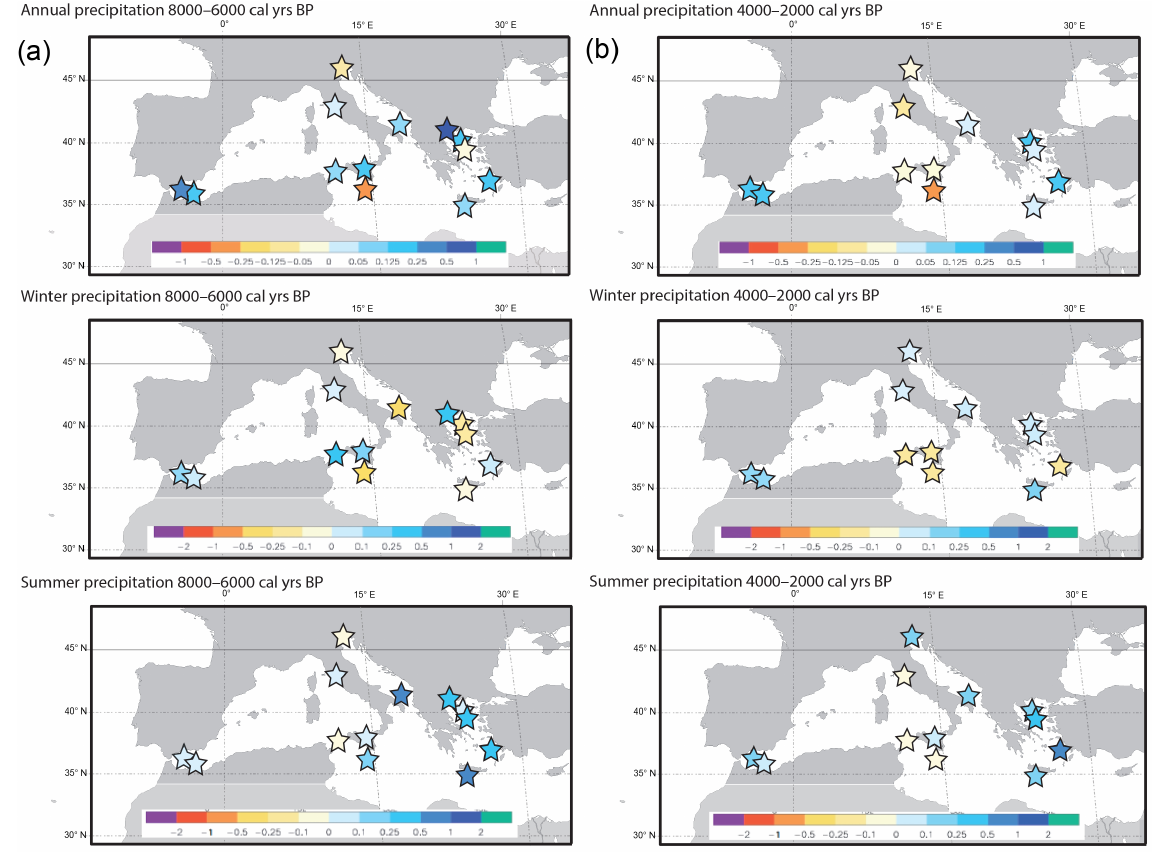
Figure 2. Pollen-inferred climate estimates as performed with the modern analogues technique (MAT): annual precipitation, winter precip- itation (winter is the sum of December, January, and February precipitation), and summer precipitation (summer is the sum of June, July, and August precipitation). Changes in climate are expressed as differences with respect to the modern values (anomalies, mmday − 1 ). The modern values are derived from the ombrothermic diagrams (see Fig. 1). Two key intervals of the Holocene corresponding to the two time slice experiments (Fig. 3) have been chosen: 8000–6000 (a) and 4000–2000 (b) calyrBP. The climate values available during these periods have been averaged